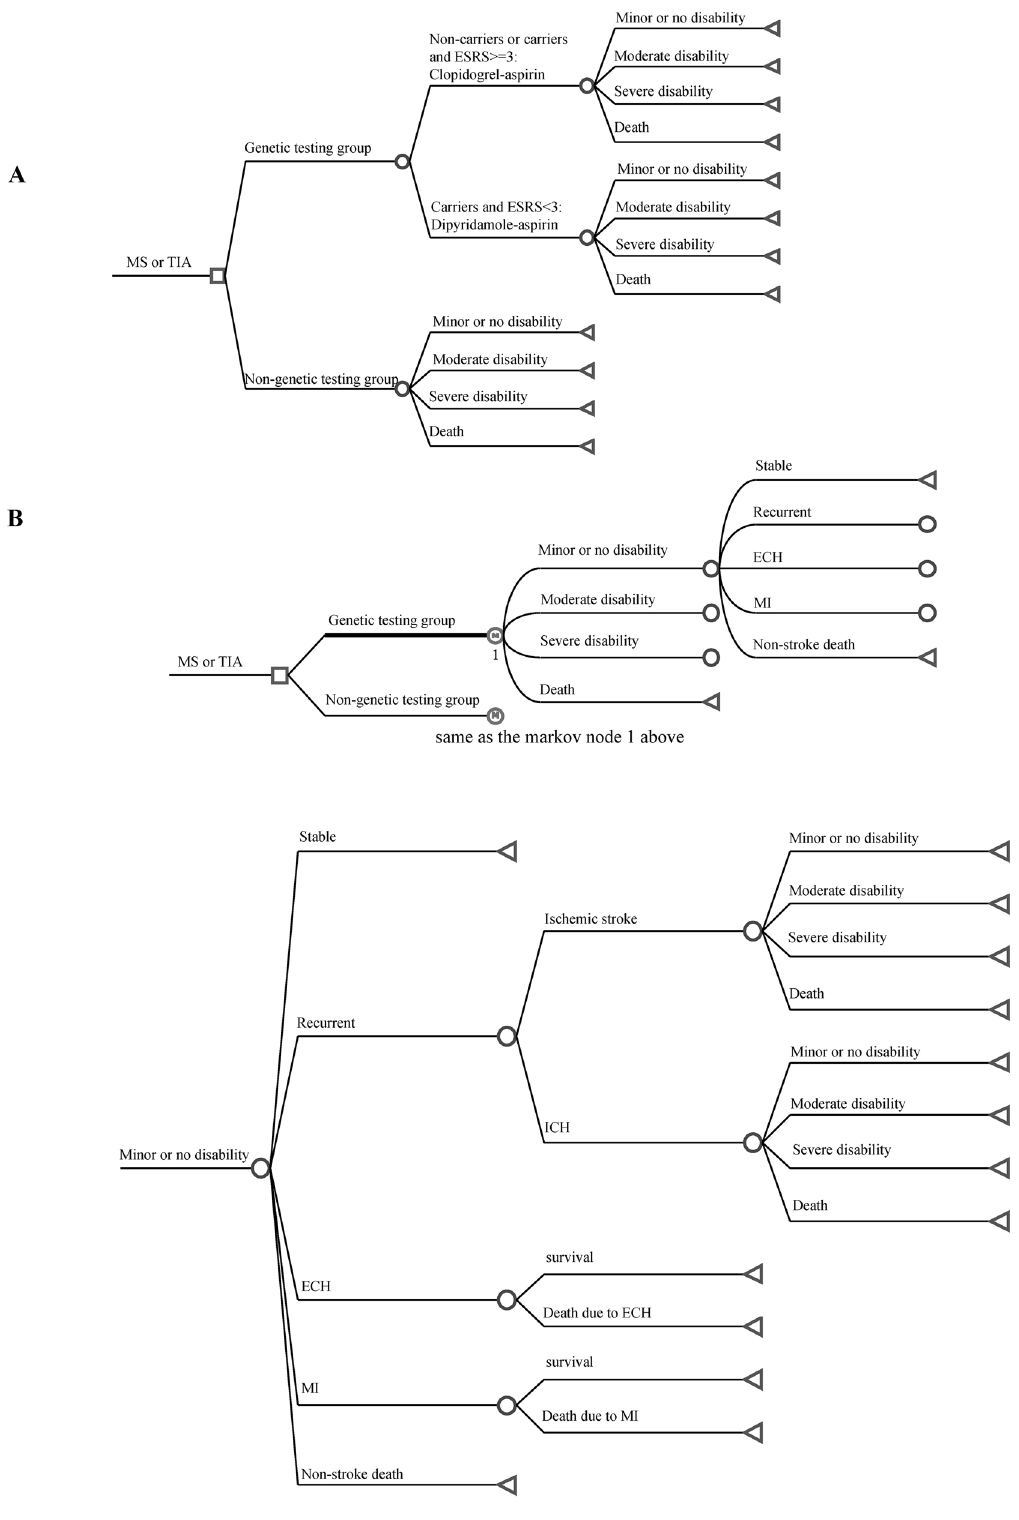
Figure 4. Model structure of cost-effectiveness analysis. ( A ) is the decision tree model within 90 days, and ( B ) is the long-term Markov model. Locations in the model where prescribers can make a decision (squares), chance nodes that are under the control of transition probabilities (circles), and terminal nodes (triangles) are presented. Transitions to future health states leading from the other health states are the same as for the minor or no disability branch. ECH extracranial hemorrhage, ICH intracerebral hemorrhage, MI myocardial